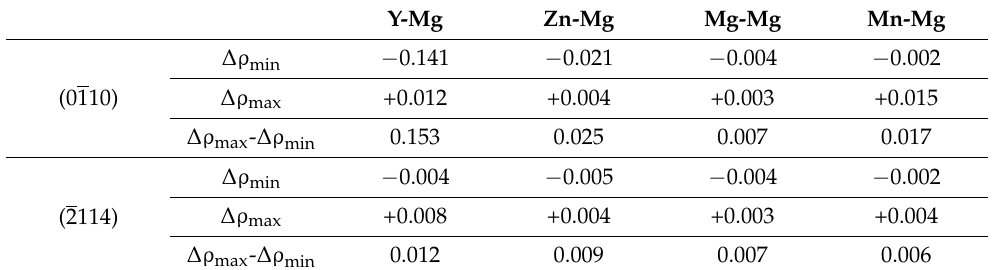
Table 1. The variation of charge density redistribution ( e /Å 3 ) upon formation of X–Mg (X = Y, Zn, Mg, and Mn) bonds in the (0 1  10) and ( 2  114) planes at the ( 2  114) twin boundary in Mg (see Figure 2).